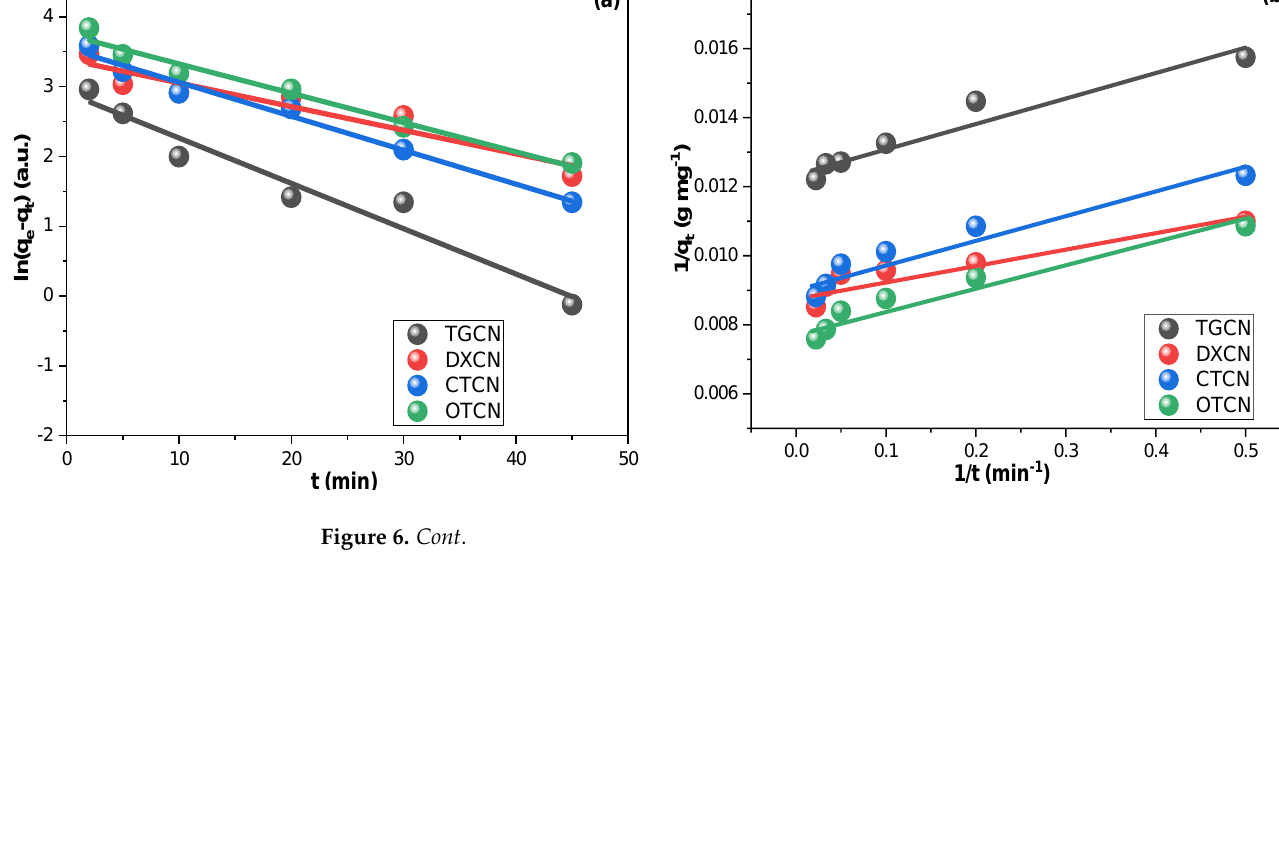
Figure 6. (a) PSFOM, (b) PSSOM (c) LFD, (d) IPD investigations for the adsorption of TGCN, DXCN, CTCN, and OTCN on the synthesized CRNPs from 100 mg L −1 solutions at 25